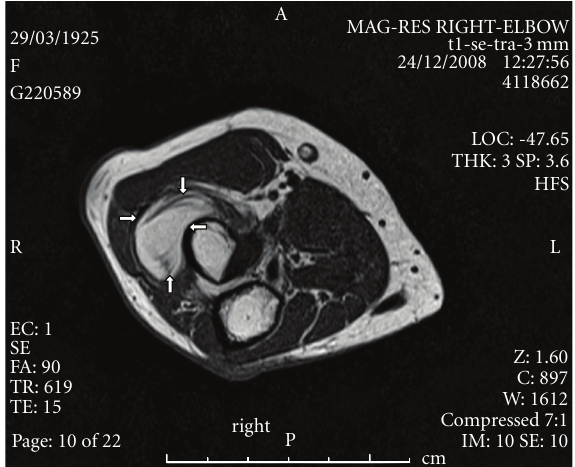
Figure 1: T1-weighted axial MR images reveal a high-intensity lesion around the radius, white arrows.